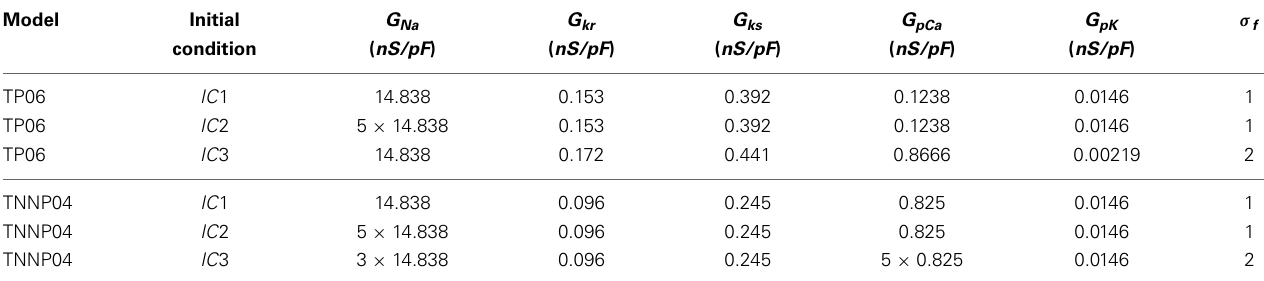
Table 2 | Parameters for the initial spiral-wave configurations for TP06 and TNNP04 models; we refer to these as IC 1, IC 2, and IC 3 initial